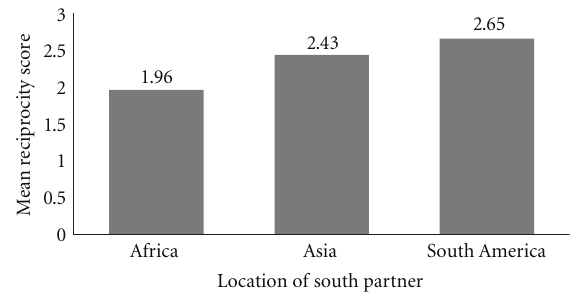
Figure 3: Average reciprocity score di ff ers by location of south partner of the north